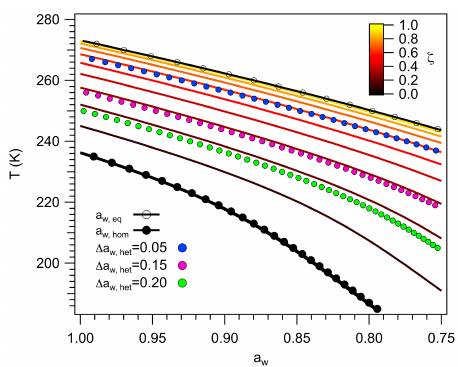
Figure 7. Thermodynamic freezing temperature as a function of wa- ter activity. Colored lines correspond to T ft (a w = a w , het ) for differ- ent values of ζ . Also shown are the water activities at equilibrium and at the homogeneous freezing threshold, a w , eq and a w , hom , re- spectively, and lines drawn applying constant water activity shifts, (cid:49)a w , het , of 0 . 05, 0 . 15 and 0 . 20.